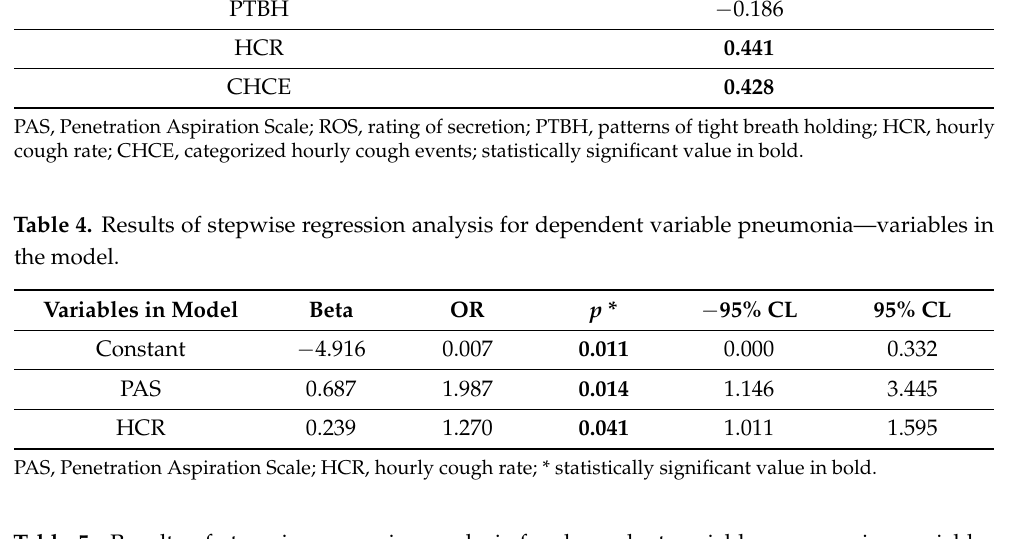
Table 5. Results of stepwise regression analysis for dependent variable pneumonia—variables outside the